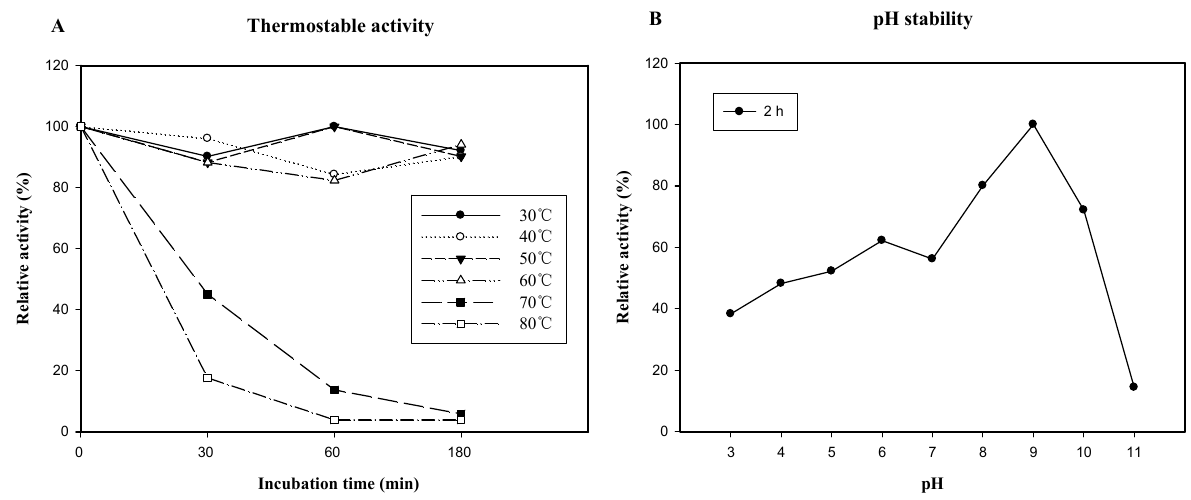
Figure 5. Effect of temperature and pH on the activity of recombinant endoglucanase B. ( A ) Thermostability of recombinant EGLB. The recombinant enzyme was pre-incubated at various temperatures in 50 mM Na-acetate buffer (pH 5.0) in the absence of substrate. Aliquots were taken at specific time points for the measurement of residual activity by the standard assay method (Section 3.11). ( B ). The pH stability of recombinant EGLB was determined by pre-incubating the enzyme at 37 °C for 2 h in different buffers (50 mM, pH 3.0–11.0). After adjusting each enzyme solution to pH 4.0, the remaining enzyme activity was determined by the standard assay method. Each value represents the mean of triplicate measurements, and varied from the mean by not more than